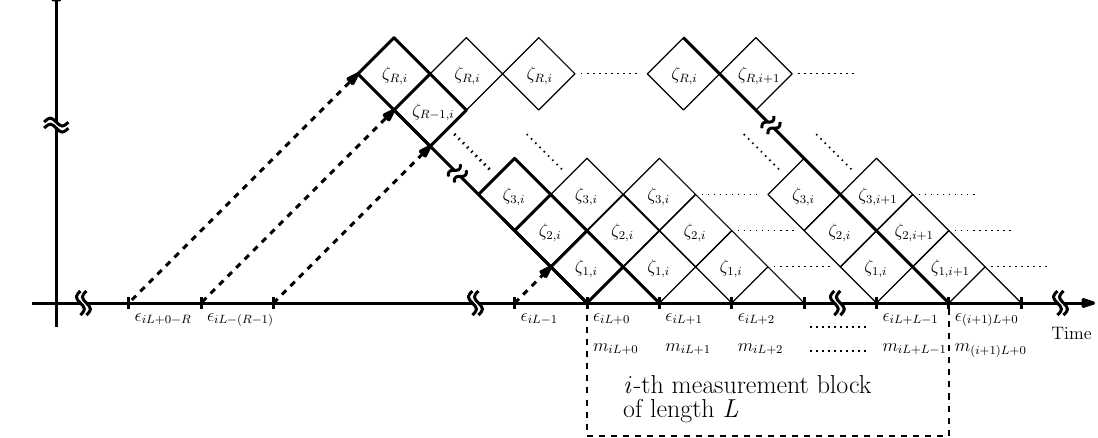
Figure 2. A range–time diagram describing the relation between coherence time, range gates, and the transmit